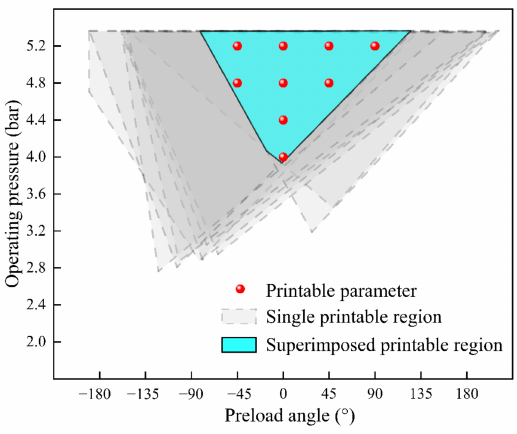
Figure 6. Printable region after superimposition.